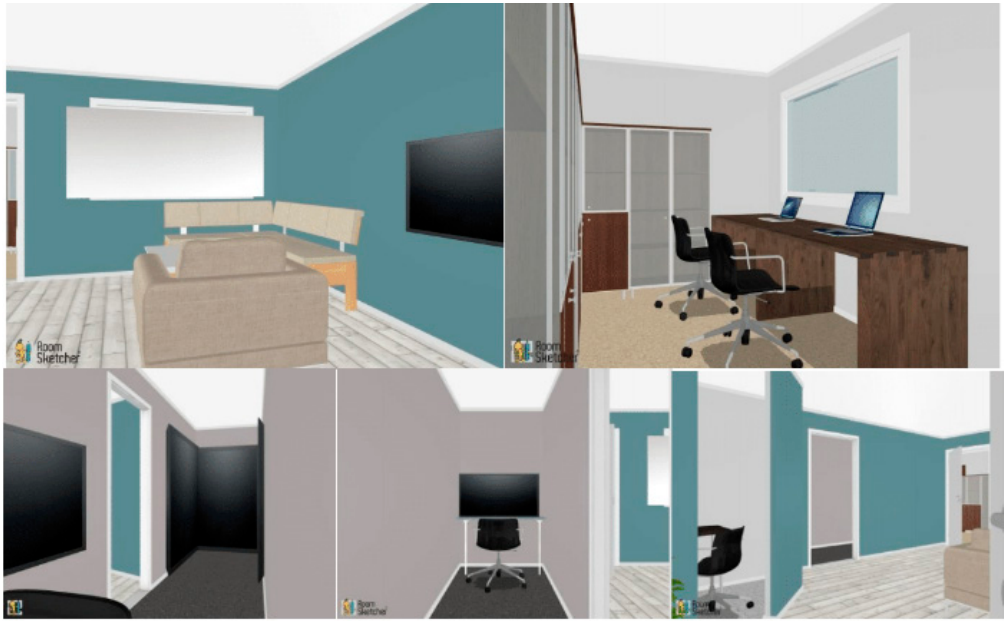
Figure 2. Initial 3D sketches of our living lab.